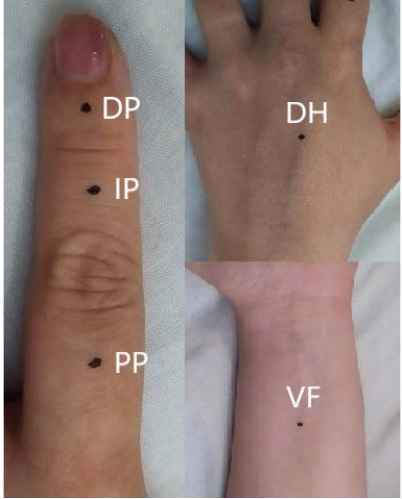
Figure 1. Skin regions of interest undergoing multiparametric non-invasive assessment. DP: distal phalanx; IP: intermediate phalanx; PP: proximal phalanx; DH: dorsum hand; VF: volar forearm.